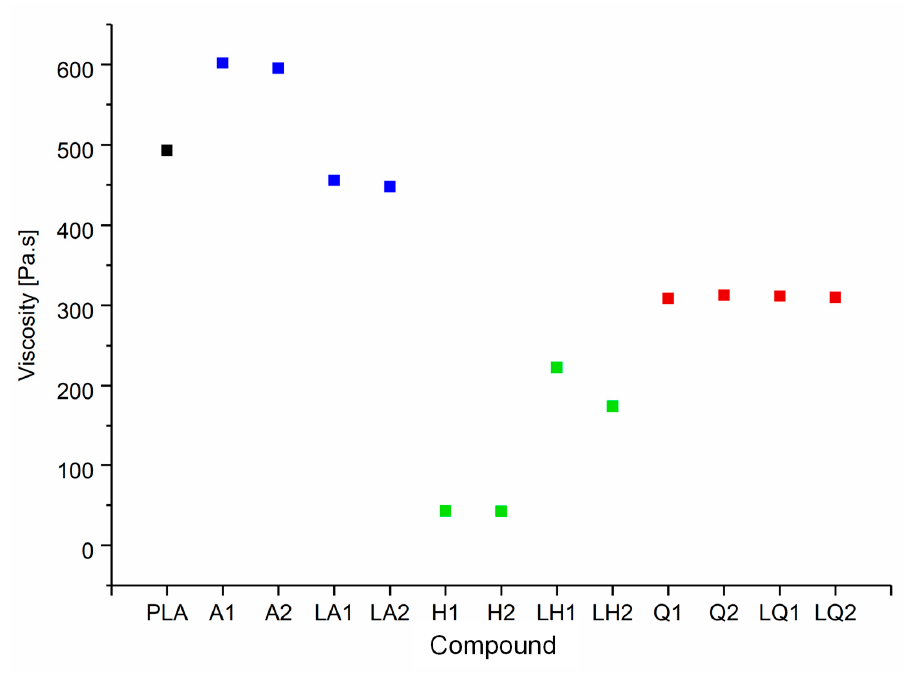
Figure 9. Shear viscosity of pure PLA and the PLA / dye compounds, corresponding to a set temperature of 200 °C and a shear rate of 5 rad/s.